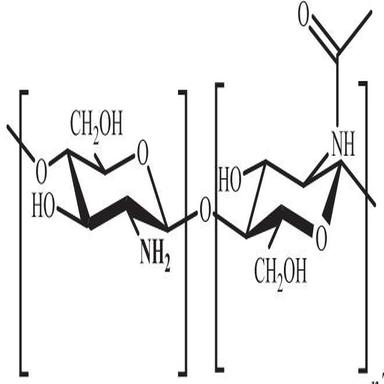
Chitosan structure.